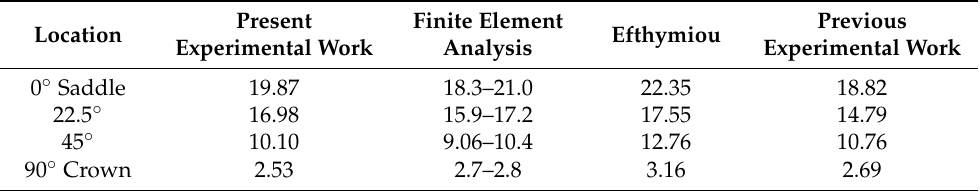
Table 8. Correlation between FEA, present and previous experimental work and Efthymiou SCFs. Location